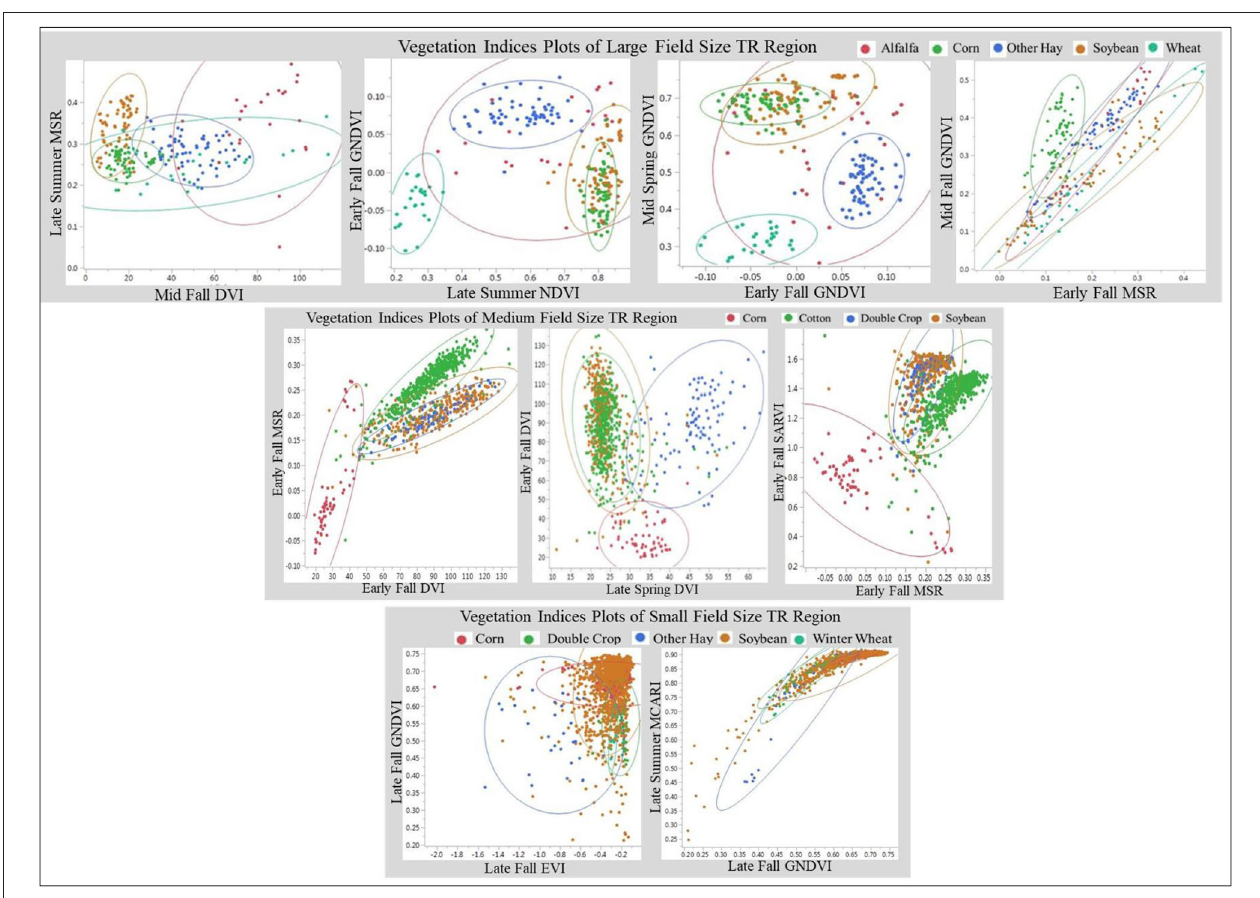
FIGURE 6 | The relationship between vegetation indices of different seasons for large, medium, and small agriculture field size TR regions.